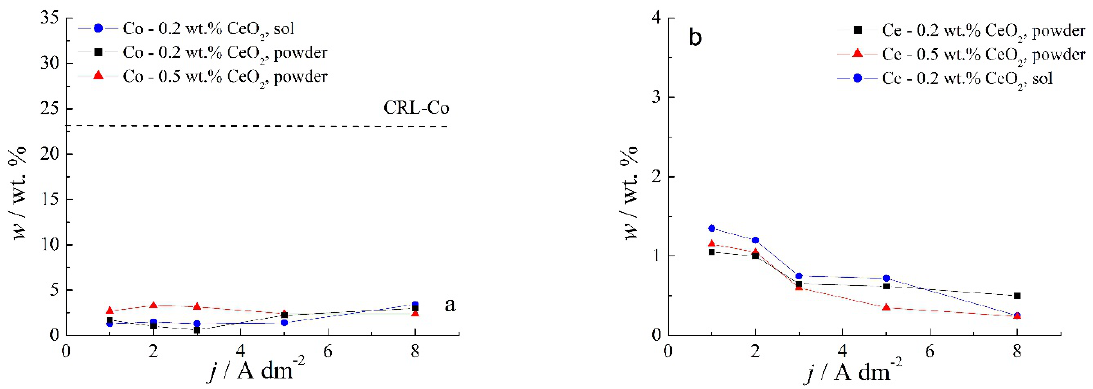
Figure 4. Dependence of the ( a ) Co and ( b ) Ce contents in Zn-Co-CeO 2 coatings on the deposition current density for the coatings deposited from the magnetically stirred solutions with different sources and amounts of CeO 2 particles.